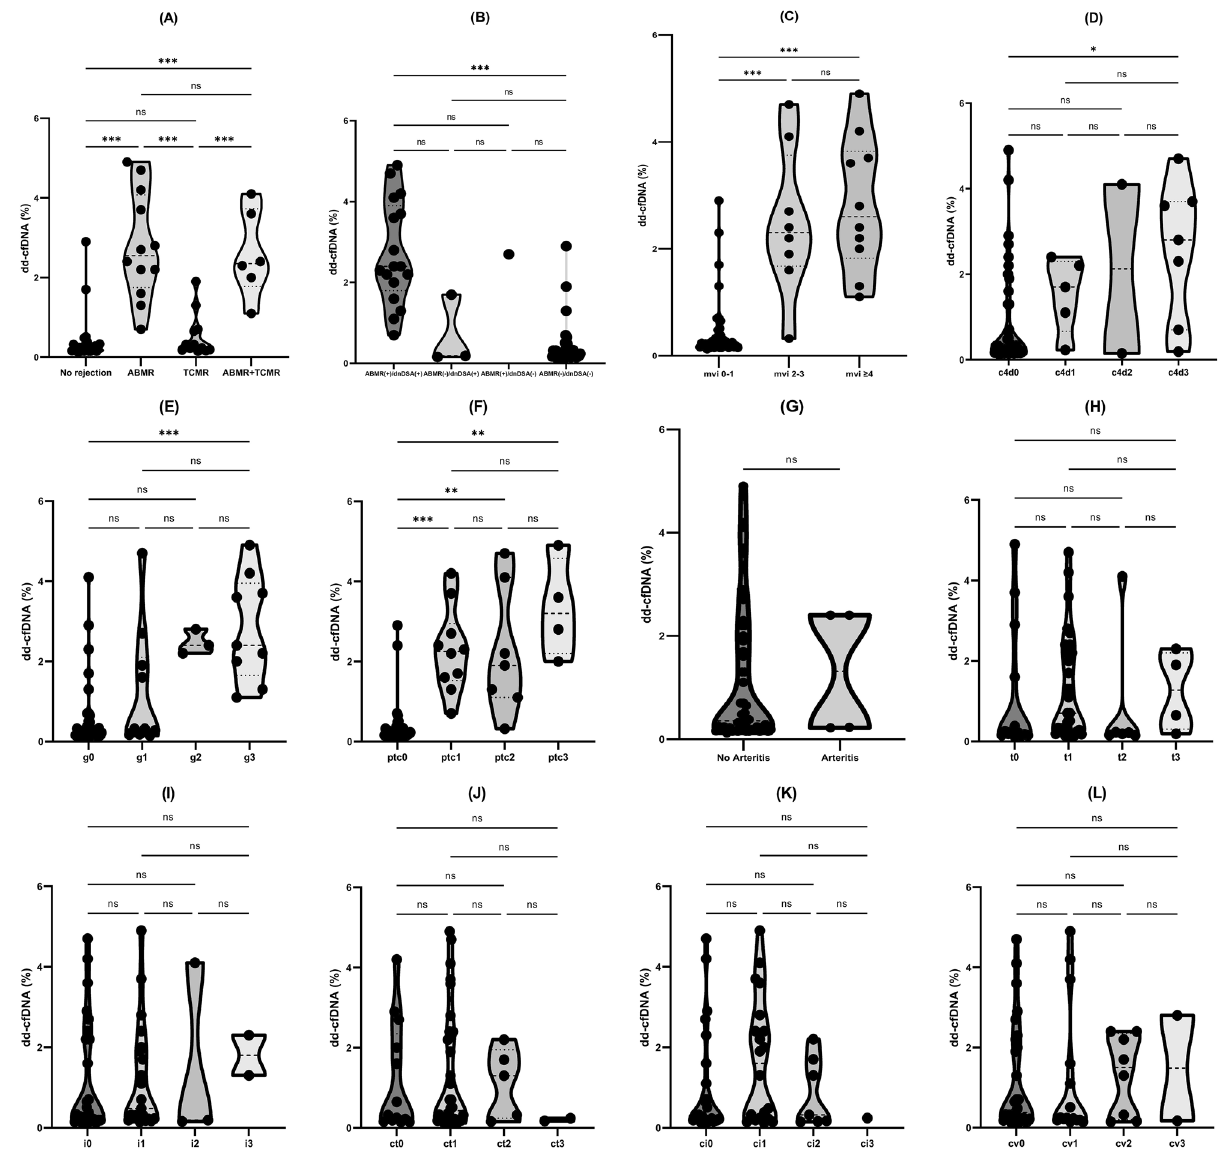
Figure 1. The absolute level of dd-cfDNA and its correlation with rejection type and individual pathological lesions (ABMR, antibody-mediated rejection; TCMR, T-cell mediated rejection; dn DSA, donor-specific antibodies; mvi, microvascular inflammation; g, glomerulitis; ptc, peritubular capillaritis; t, tubulitis; i, interstitial inflammation; ct, tubular atrophy; ci, interstitial fibrosis; cv, arteriosclerosis. Differences of dd-cfDNA levels were assessed by Mann–Whitney or Kruskal–Wallis testing, as appropriate; p-values are reported as following: *p between 0.01 and 0.05, **p between 0.001 and 0.01, ***p <